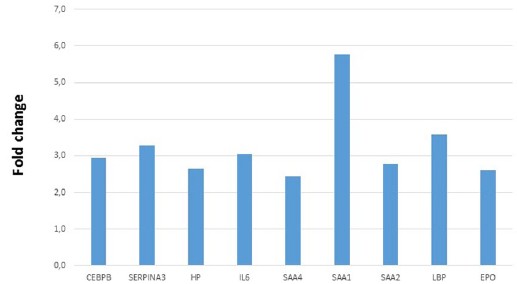
Figure 2. Differential expression of genes involved in acute-phase response in the top 10% of tumors expressing MFI2-AS1 compared to the bottom 10%. CEBPB : CCAAT/enhancer binding protein beta(CEBPB), EPO: erythropoietin, HP: haptoglobin, IL6 : Interleukin 6, LBP: lipopolysaccharide binding protein, SERPINA3 : Serpin A3, SAA: serum amyloid protein.